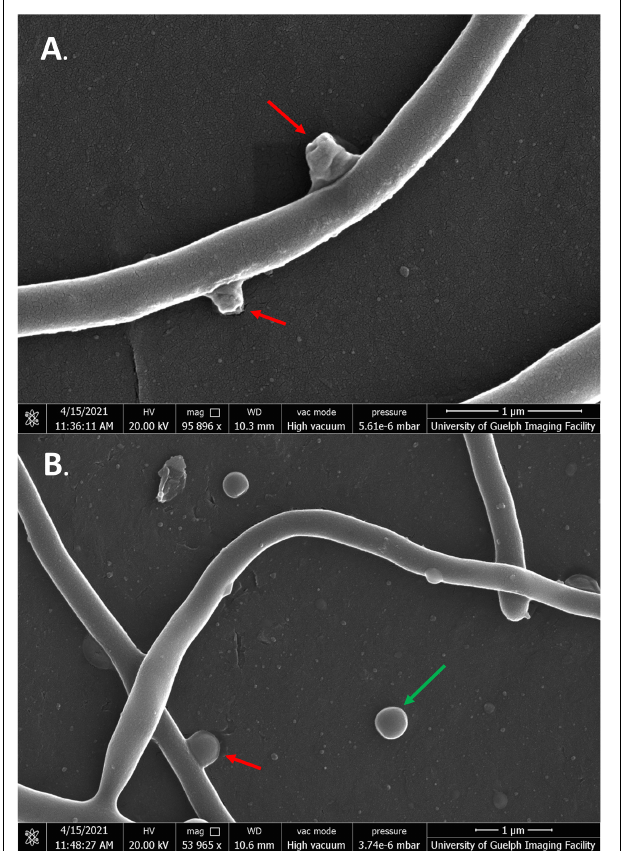
FIGURE 5 | SEM images of S . scabies grown in the absence of flavonoids. (A) S. scabies grown overnight in nutrient broth with a metal spring for shearing. (B) S. scabies grown overnight in nutrient broth plus 4% DMSO with a metal spring for shearing. Red arrows point to putative branching hyphae. Green arrow points to fluid filled vesicle. Images were taken via a Quanta 250 FEG SEM (FEI company, OR, United States).